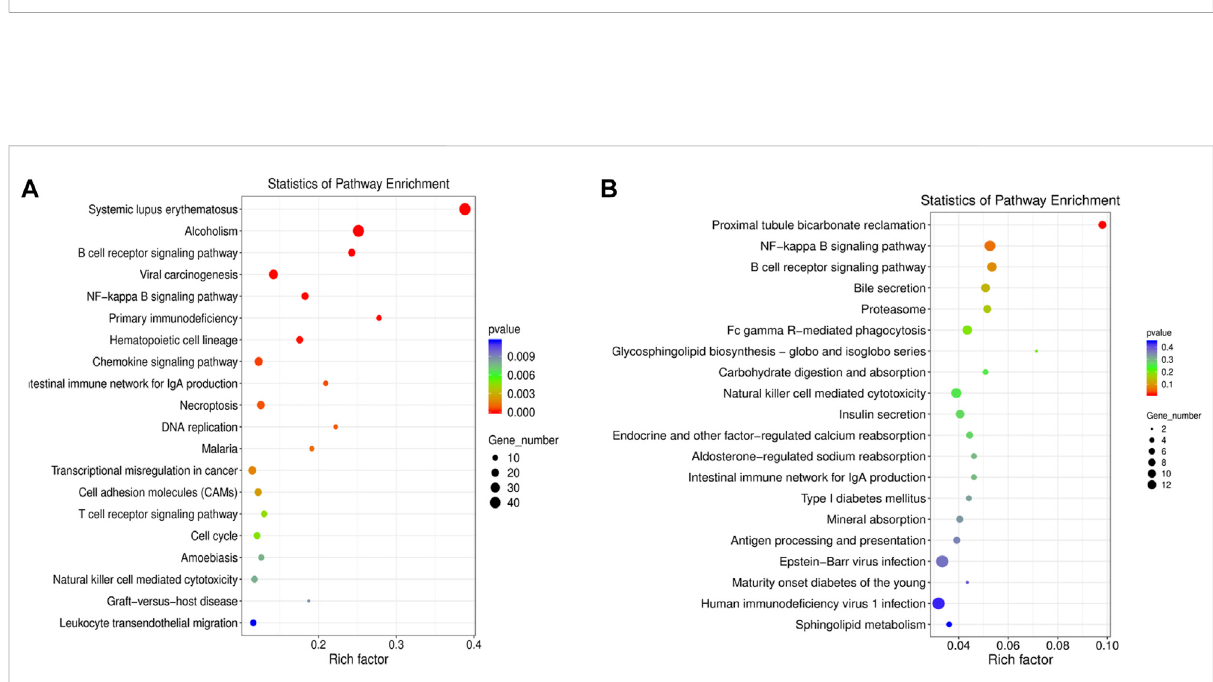
GO and KEGG pathway enrichment analysis of the differentially expressed (DE) mRNAs and DE LncRNAs-targeting genes. (A) KEGG pathway enrichment analysis of the DE mRNAs. (B) KEGG pathway enrichment analysis of the DE lncRNAs-targeting genes.